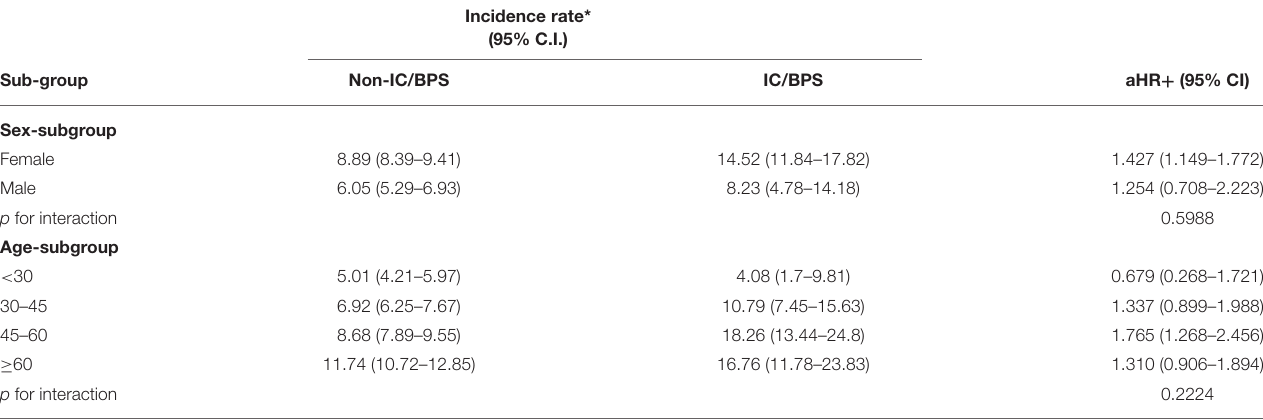
TABLE 4 | Sub-group analysis in age-sex matched population.